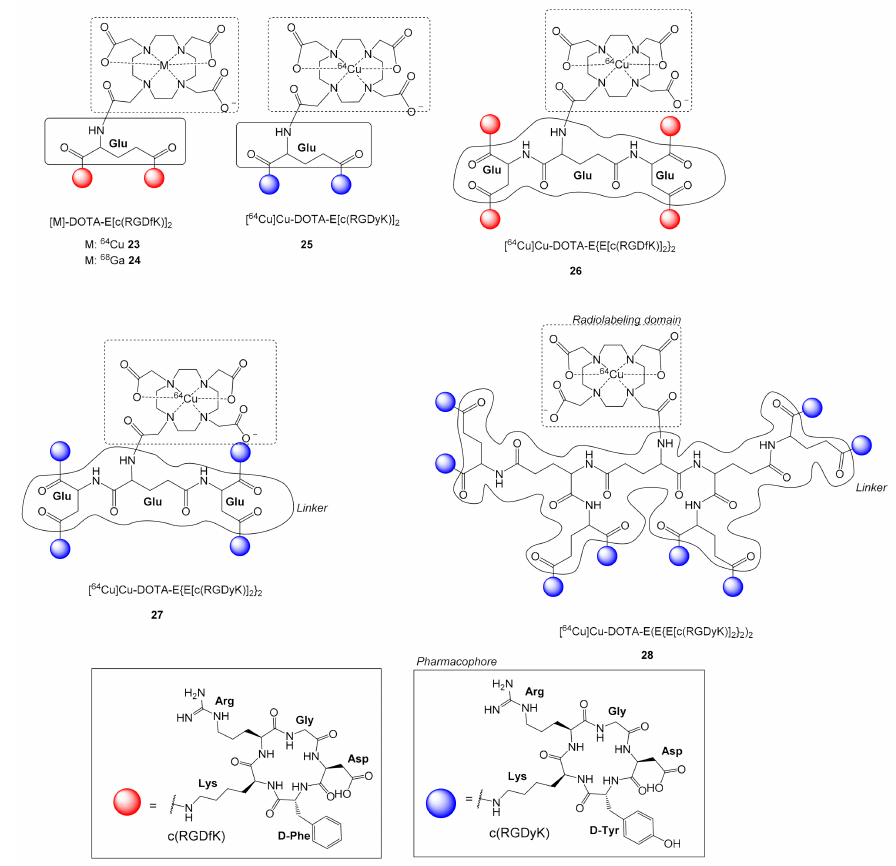
Figure 8. Chemical structures of 64 Cu-labeled c(RGD) peptides with (Glu) n linkers, [M]-DOTA-E[c(RGDfK)] 2 , where M = 64 Cu: 23 , M = 68 Ga: 24 , [ 64 Cu]Cu-DOTA-E[c(RGDyK)] 2 25 and the c(RGD) tetramers [ 64 Cu]Cu-DOTA-E{E[c(RGDfK)] 2 } 2 26 and [ 64 Cu]Cu-DOTA-E{E[c(RGDyK)] 2 } 2 27 and the cRGD octamer [ 64 Cu]Cu-DOTA-E(E{E[c(RGDfK)] 2 } 2 ) 2 28